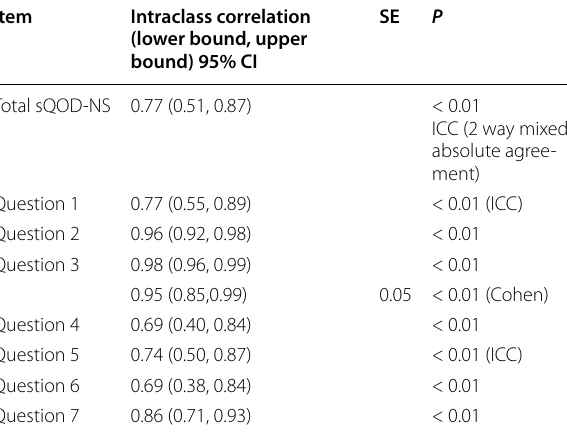
Table 6 Reliability result of each item in Malay version